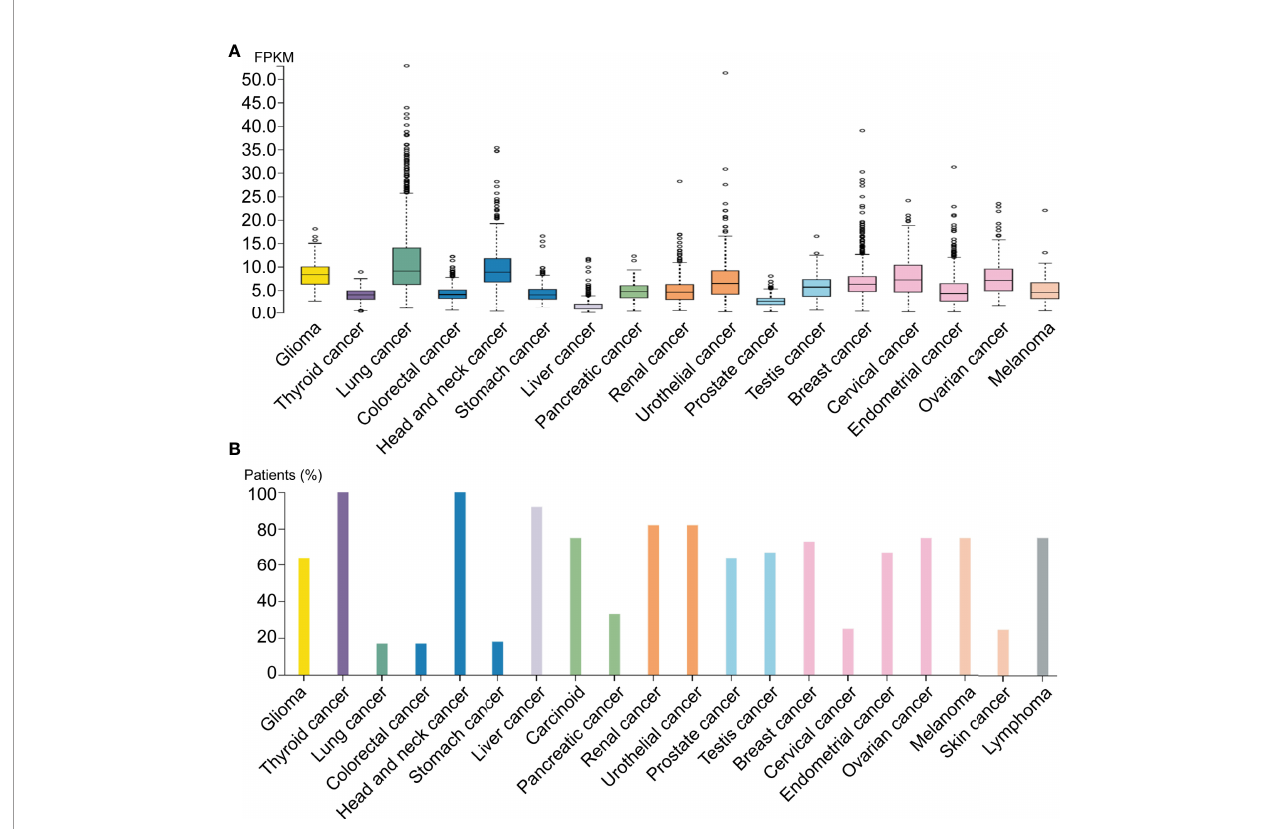
FIGURE 3 | ADAM17 expression levels in different human cancers. (A) ADAM17 mRNA expression in different cancer tissues. (B) The protein expressions of ADAM17. In each cancer type, color-coded bars show the percentage of patients with high and medium levels of ADAM17 protein. The cancer types are color- coded according to organ type, and cancer